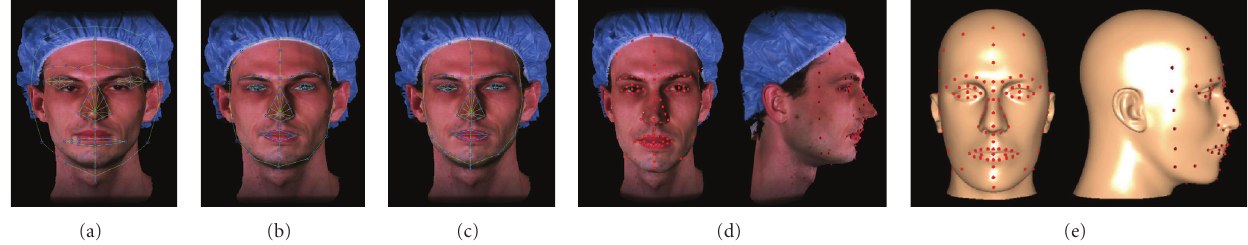
Figure 3: Semi-automatic feature point identification: (a) initial outline of the feature mask; (b) after automatic facial feature detection; (c) after interactive tuning; (d) and (e) 3D feature points identified on the scanned model and the generic model.